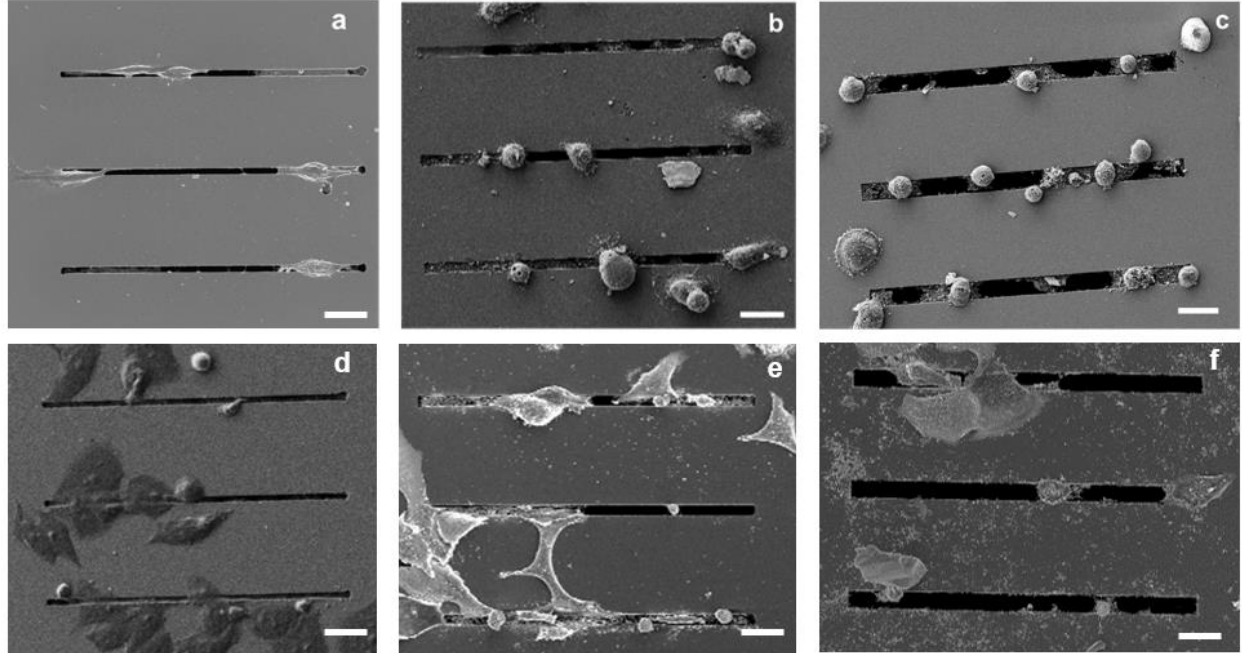
Figure 3. SEM images of MDA-MB-231 cancer cells cultured on microstructures with different gap sizes: 2 μm ( a ), 4 μm ( b ), and 8 μm ( c ); SEM images of MCF-7 cancer on microstructures with different gap sizes: 2 μm ( d ), 4 μm ( e ), and 8 μm ( f ); Scale bars: 25 µm.